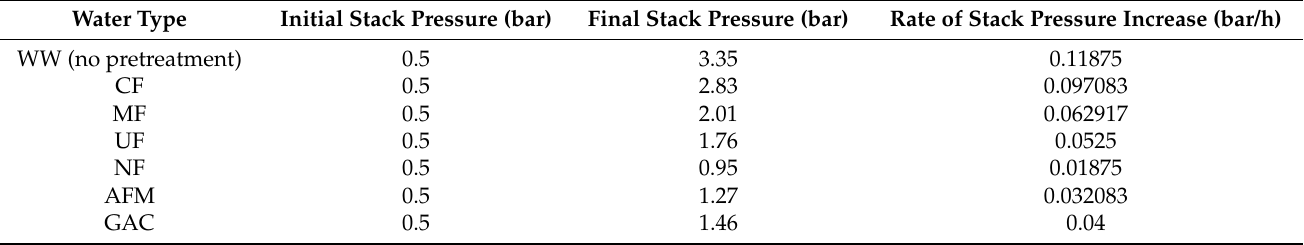
Table 8. Stack pressure in RED using raw feed water (WW) and pretreated